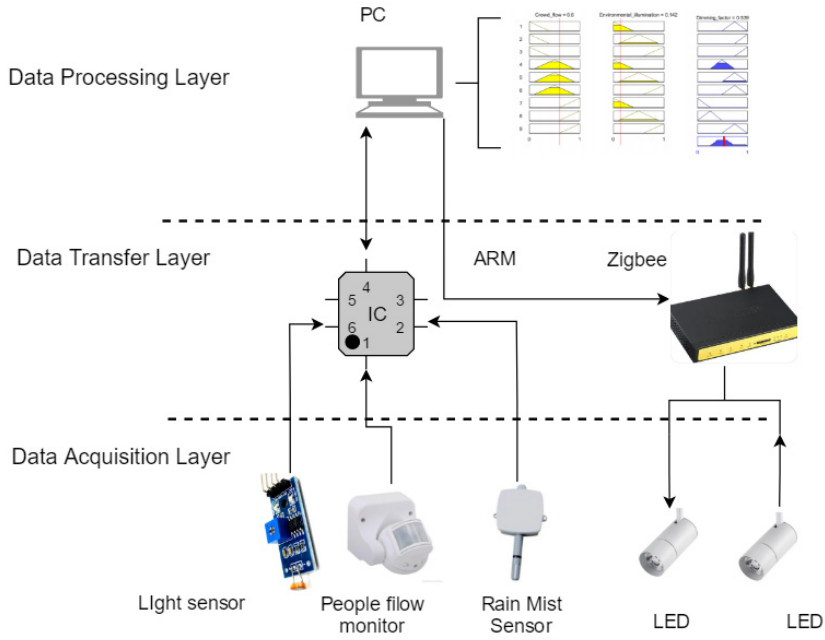
Figure 2. The architecture of the control system.